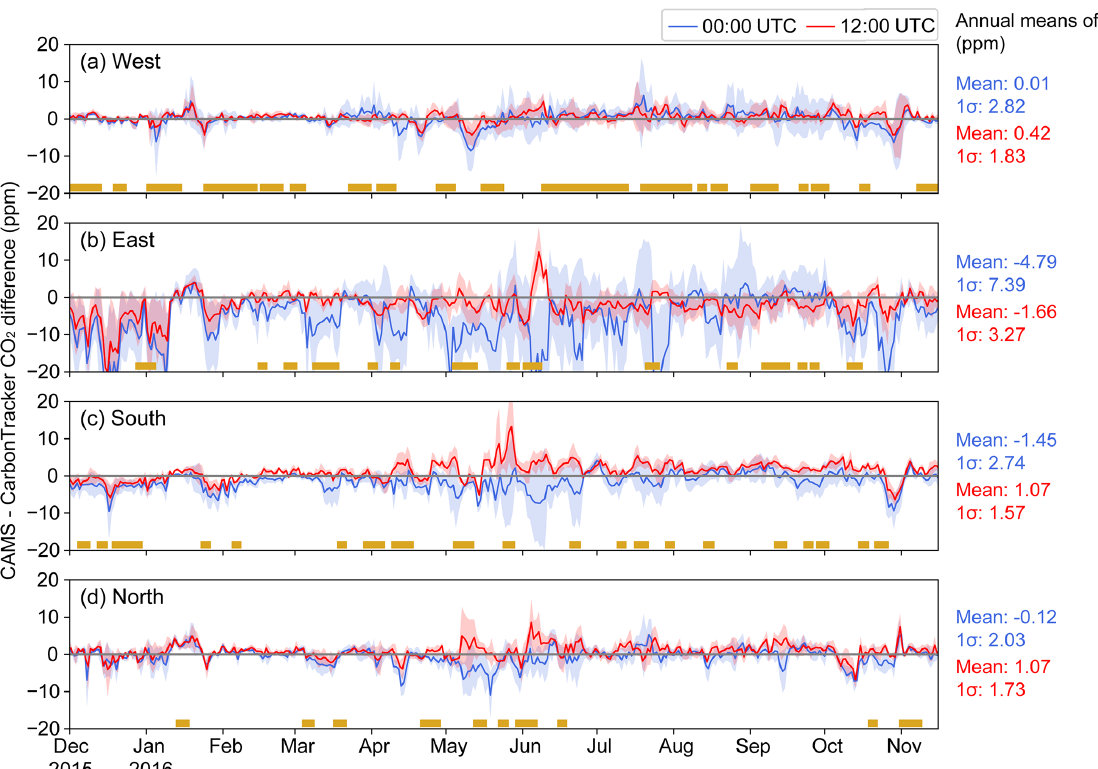
Figure 3. Time series of average CO 2 concentration differences between CAMS and CarbonTracker at four lateral boundaries (west, east, south, north), averaged over the lowest 0.7kma.g.l., of D01 for 00:00UTC in blue and 12:00UTC in red. The lines indicate the spatial means over each boundary (a latitudinal transect for western and eastern boundaries and a longitudinal transect for southern and northern boundaries). The shaded areas extend over 1 standard deviation ( ± 1 σ ) computed over the grid cells that make the lateral boundary (spatial standard deviation). The yellow symbols indicate the days when the wind blows from outside of the domain at the respective domain boundary. The numbers on the right side of the figure indicate annual means of (i) the spatial mean and (ii) the spatial standard